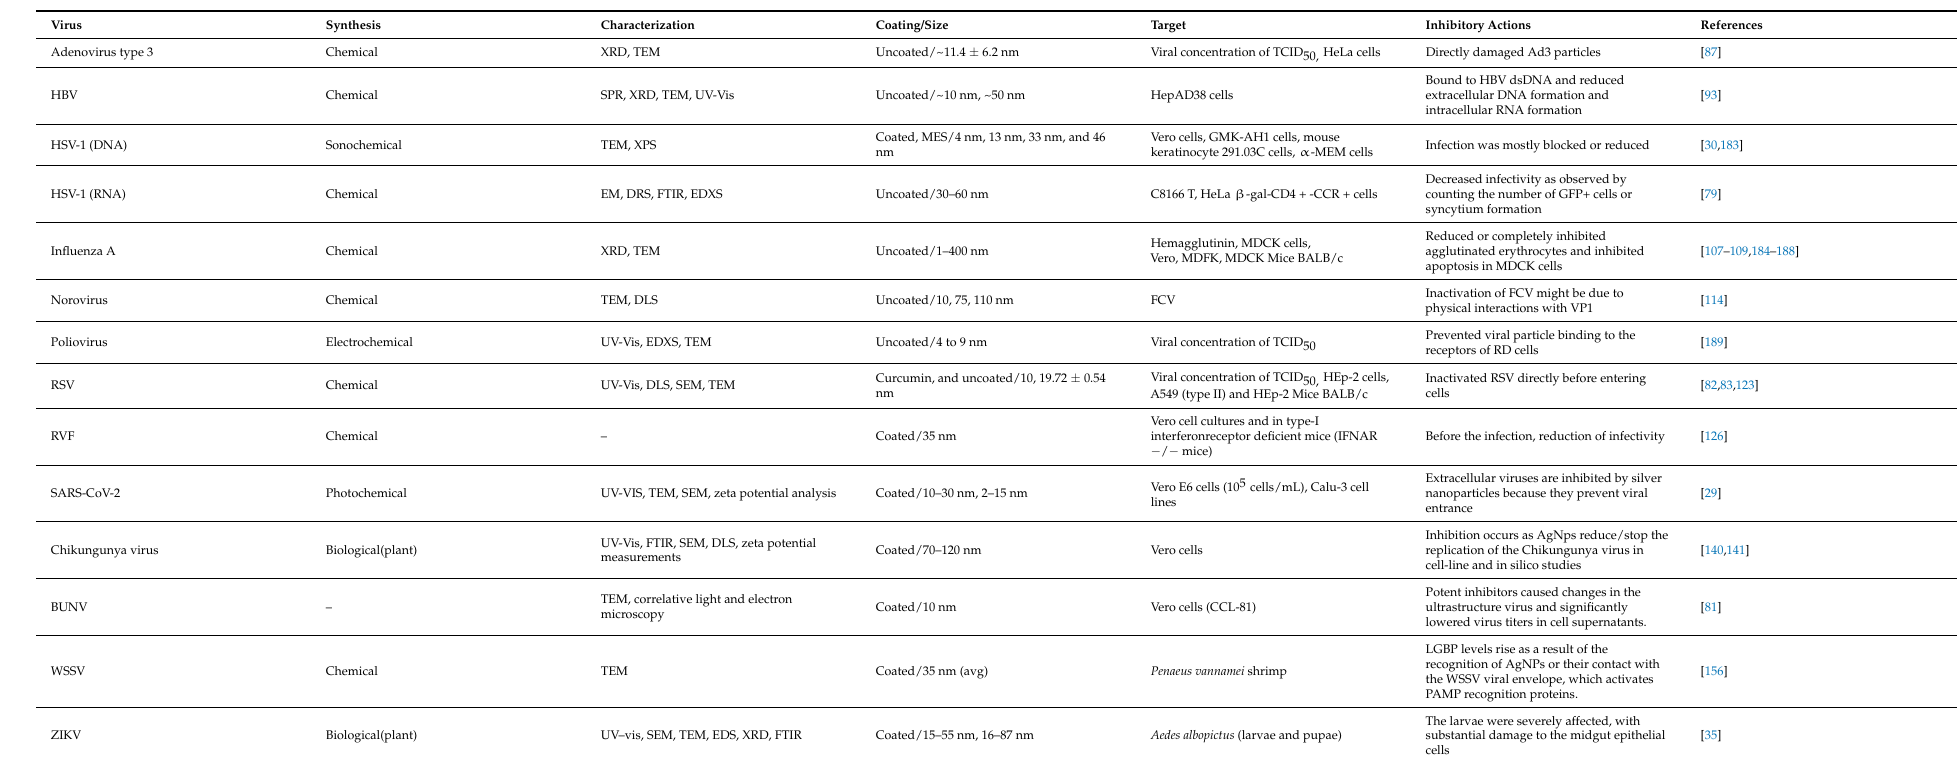
Table 2. AgNPs and their inhibitory actions against viral